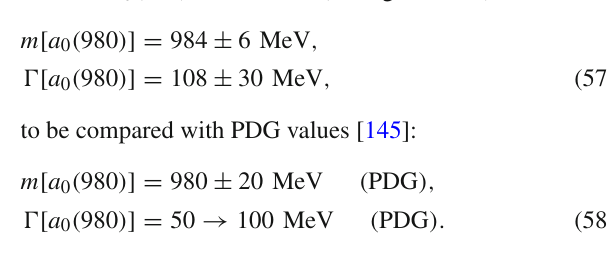
and decay width of a 0 ( 980 ) from those displayed in Fig. 15 to thosedisplayedinFig.16(left)togetherwiththeirhistograms